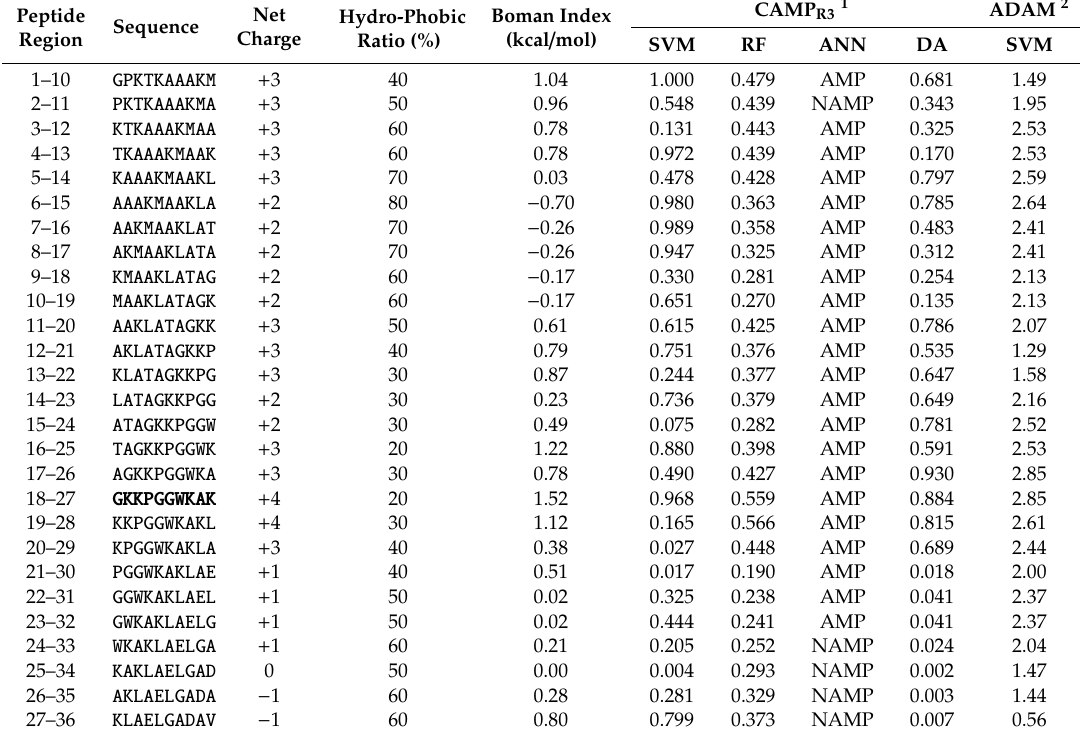
Table 1. Characteristics and in silico antimicrobial activity prediction of 10-mer peptide sequences modelled from Turgencin A lin ; a linear version of turgencin A where the Cys residues were replaced by Ala. The highlighted sequence 18–27 (GKKPGGWKAK) in bold was the only sequence that was predicted to be antimicrobial by all four in silico models.